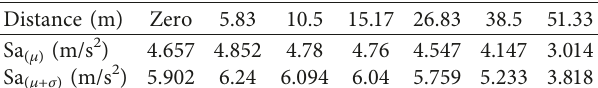
Table 10: Maximum acceleration spectrum for SF models at dif- ferent distances from the center of the tunnel image on the ground surface.